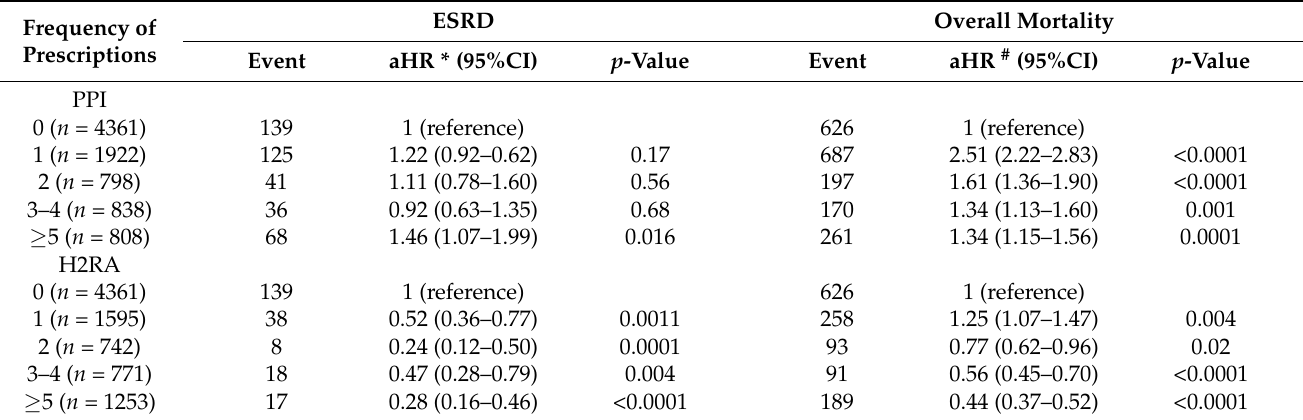
Table 5. Association between the frequency of acid-suppressant prescription and study outcomes.